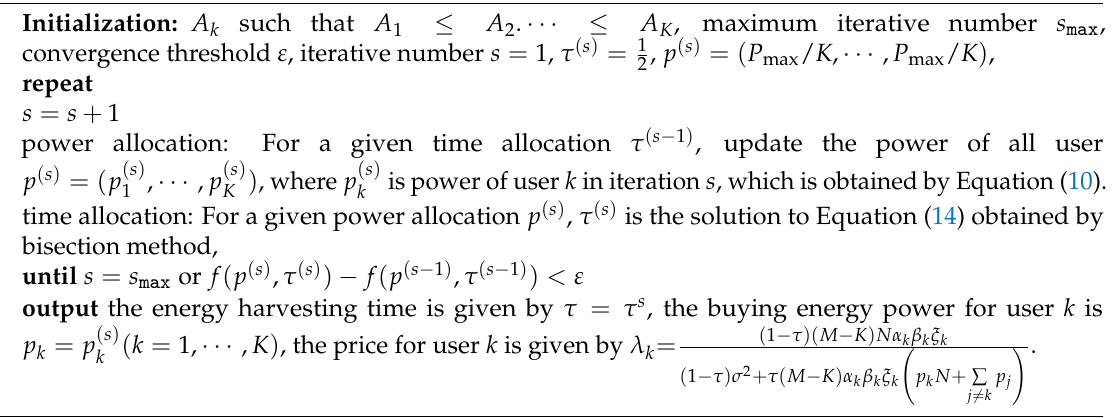
Algorithm 1 Optimal Price-based Resource Allocation Algorithm